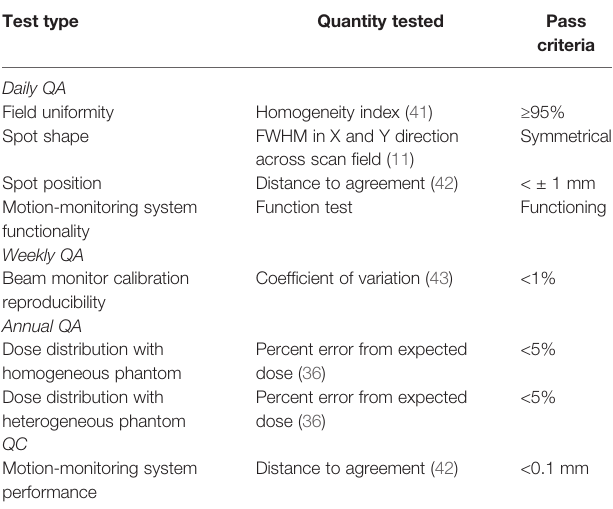
TABLE 2 | Description of the purpose and pass criteria for each quality assurance